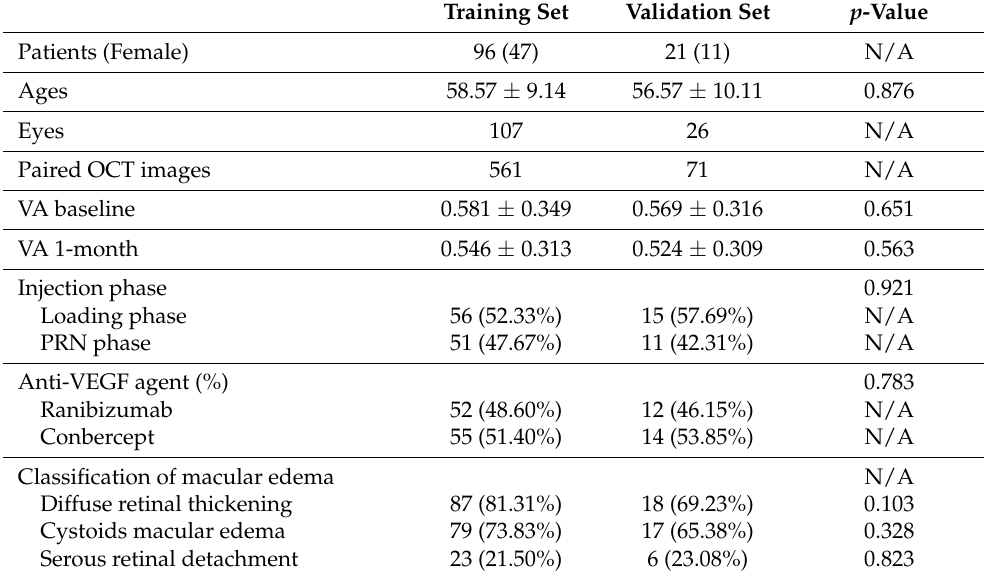
Table 1. Patient demographics.